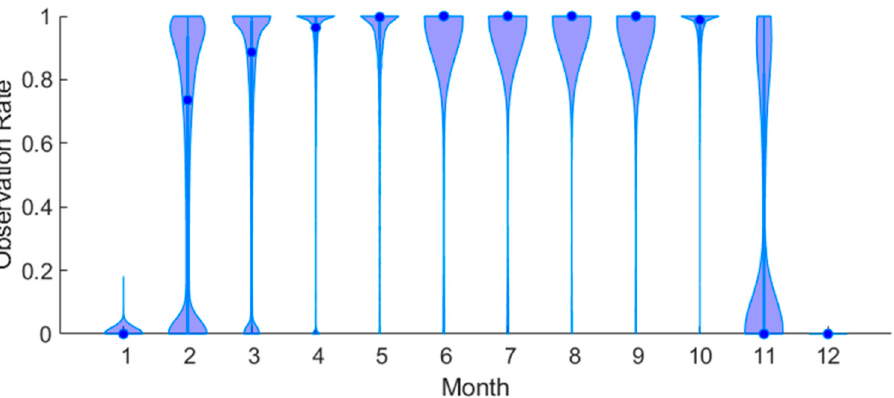
Figure 3. Violin plots (probability distribution) of observation rates for reaches in each month. Observation rate is defined as the fraction of observed pixels within maximum river extent as illustrated in Figure 2B. Filled dots represent the median values.